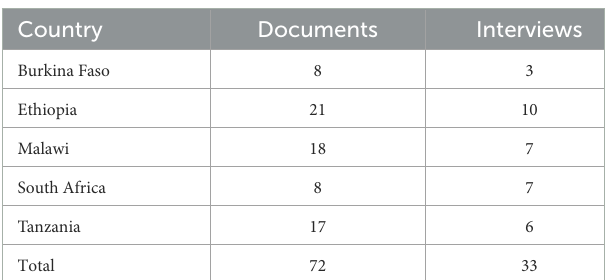
TABLE 2 Number of documents and interviews